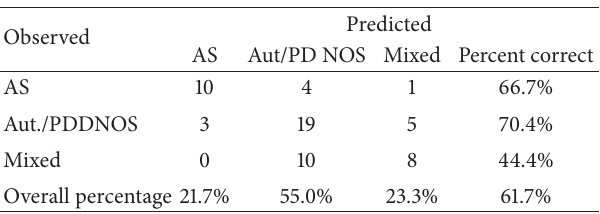
Table 2: Classification of the sample by the MASQ.